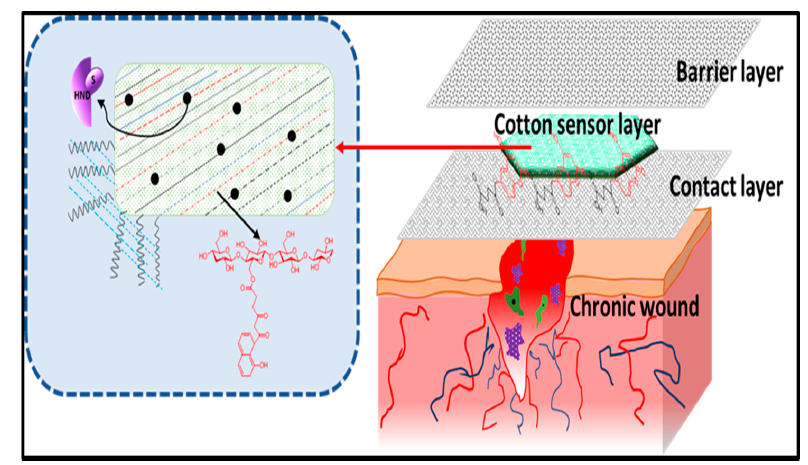
Figure 7. Cotton-based biosensor for wound dressing [103].